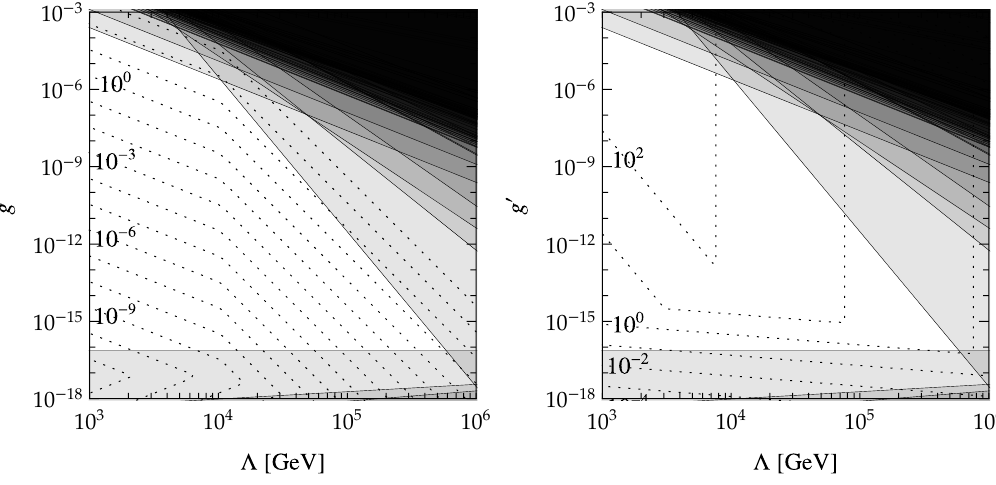
Figure 23 . Same region as in (cid:12)gure 17 (fragmentation during in(cid:13)ation) where we show the contours of the minimum (left) and maximum (right) values of the relaxion mass